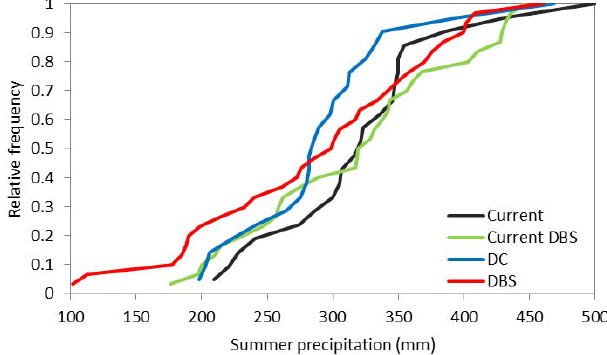
Fig. 6. Cumulative histogram of the summer precipitation for the current climate and for the DC method and the DBS method.